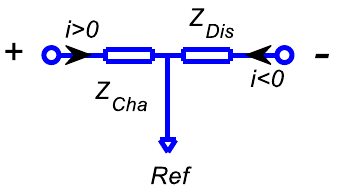
Figure 3. DC equivalent first principle impedances on electrode–electrolyte interfaces.